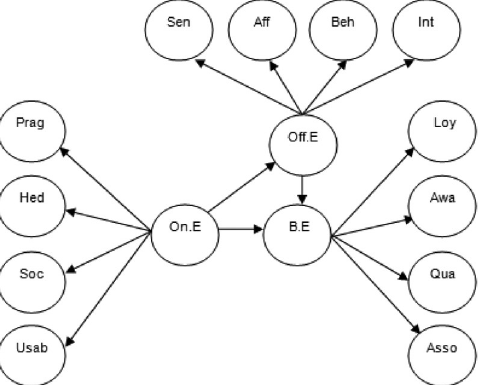
Figure 2. Model of structural equations